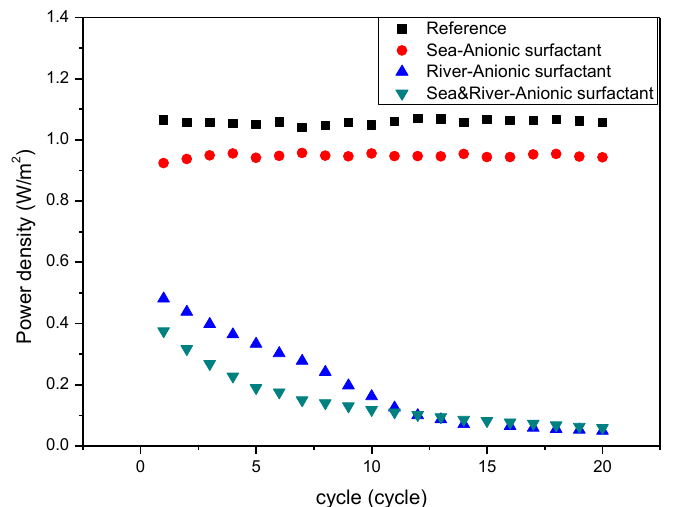
Figure 3. Variation of power density of the RED systems with the number of operation cycles with respect to the presence of the anionic foulant (SDS) included in seawater, river, or